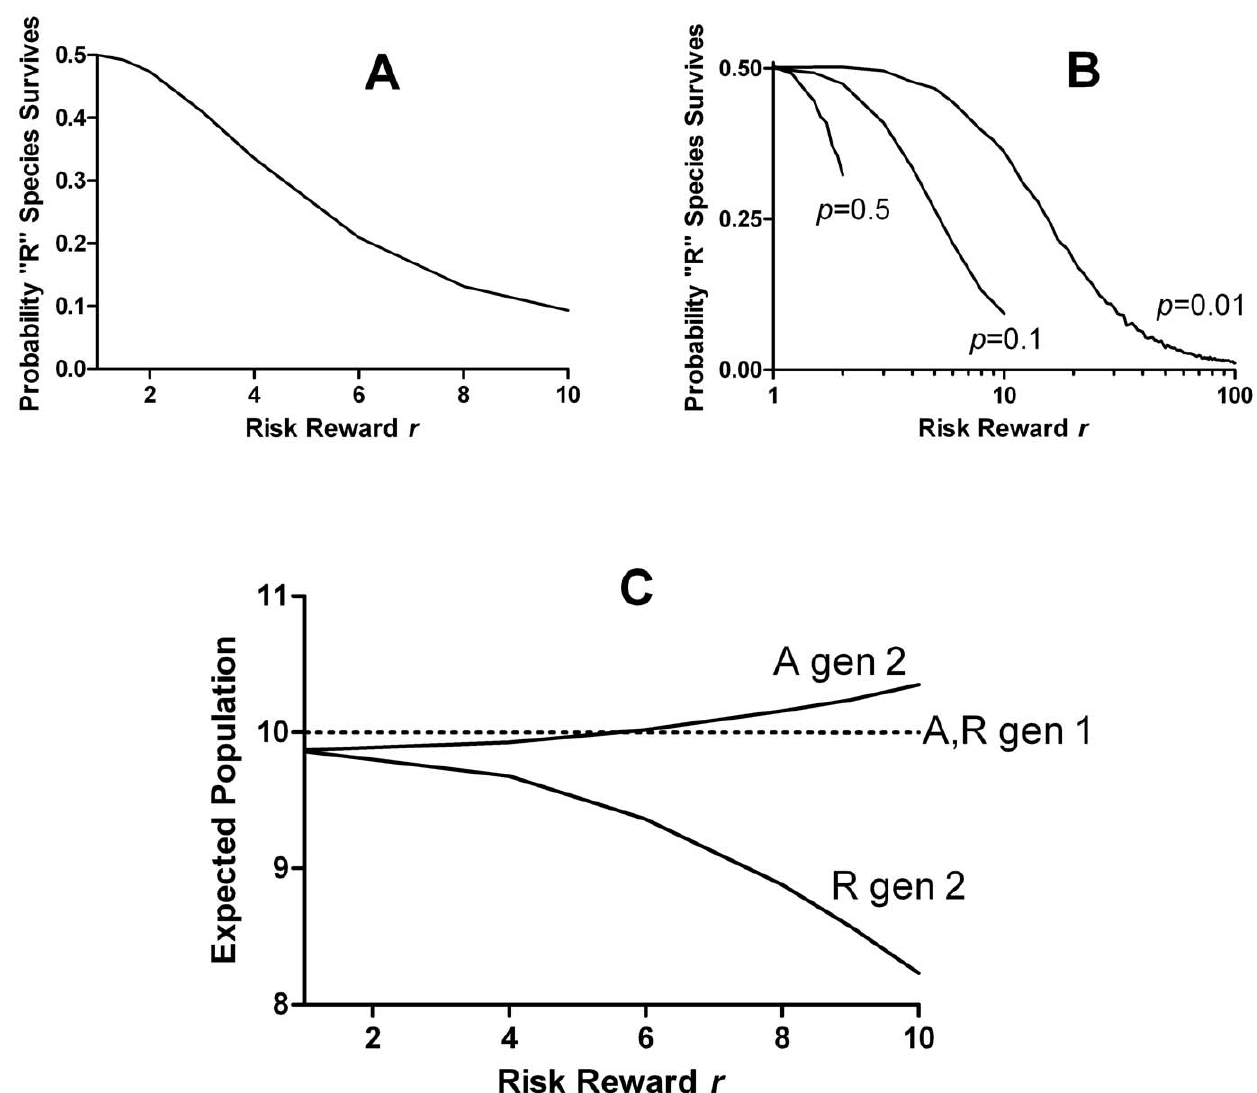
Figure 2. Intrinsic selection against risk-taking species. A. The fraction of 10,000 trials in which the ‘‘R’’ species survived the selection, as a function of the risk-reward r . The probability p of the risk event was kept constant at 0.1, and n max at 150 Higher values of r indicate a higher reproductive advantage for the 10% of ‘‘R’’ organisms that ‘‘win’’ the risk event, but also a correspondingly greater penalty for the 90% that lose, so that the overall expected fecundity remains at 2. When r =1/ p , the losers leave no descendants. B. Similar to A, but showing different values of the long-shot probability p . C. Analytically computed expectation values of the populations of ‘‘R’’ and ‘‘A’’ organisms after 1 or 2 generations, starting from 10 of each, with the deterministic saturation population size set to 20 and p =0.1. The effect of risk to depress the expected ‘‘R’’ population appears only in the second generation, due to correlation between fecundity fluctuations in the first generation and population competition in the second. Note that even when r =1 both populations are slightly depressed due to the effect of Poisson fluctuations in individual